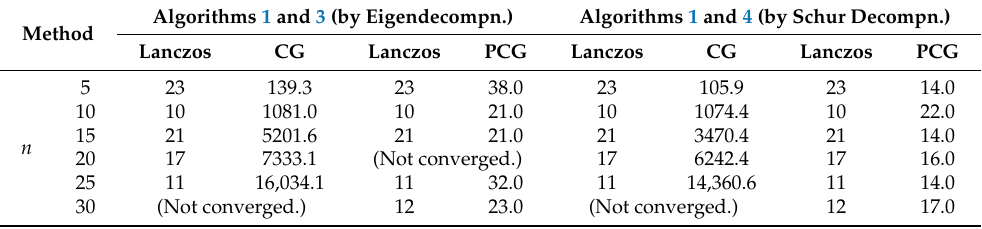
Table A2. Number of iterations of the Lanczos method and the average of numbers of iterations of the CG/PCG method in the case of the median of singular value of slightly symmetric matrix T with a = c = 1 and b = 0.1 in (9) for the shift (A1). Algorithms 1 and 3 (by Method